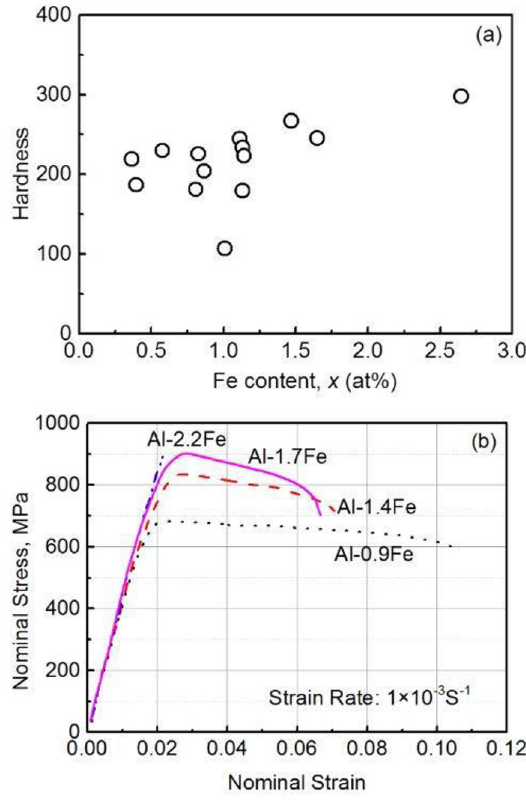
Figure 11. Relationship between (a) Fe content and Vickers hardness and (b) Stress-Strain curve of Al-Fe deposited alloy 52 .